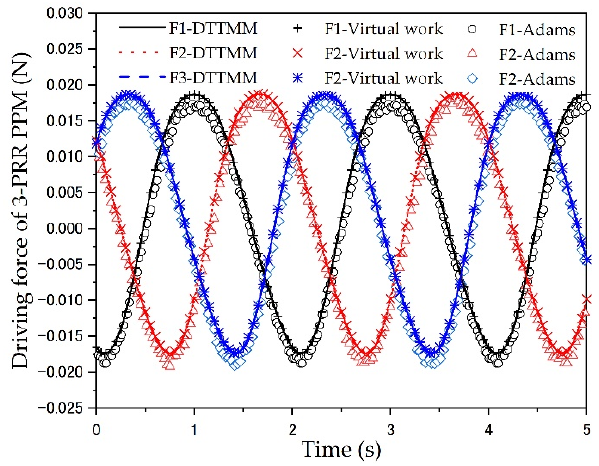
Figure 7. Driving force of the 3-PRR PPM.